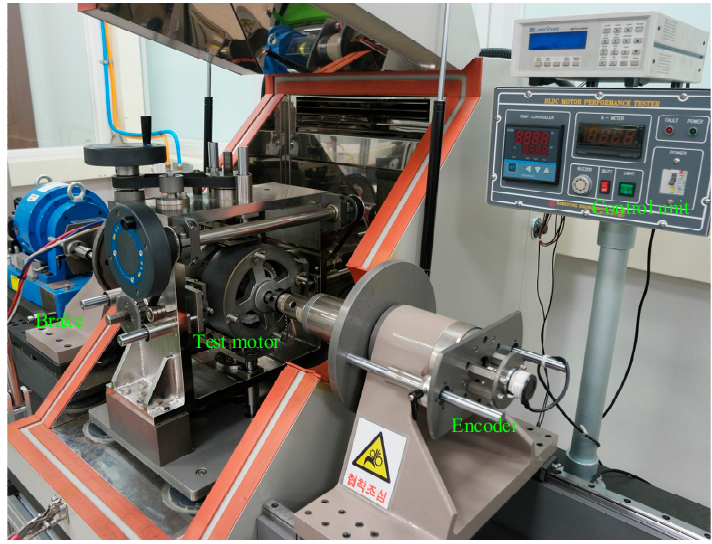
Figure 12. Experimental setup.